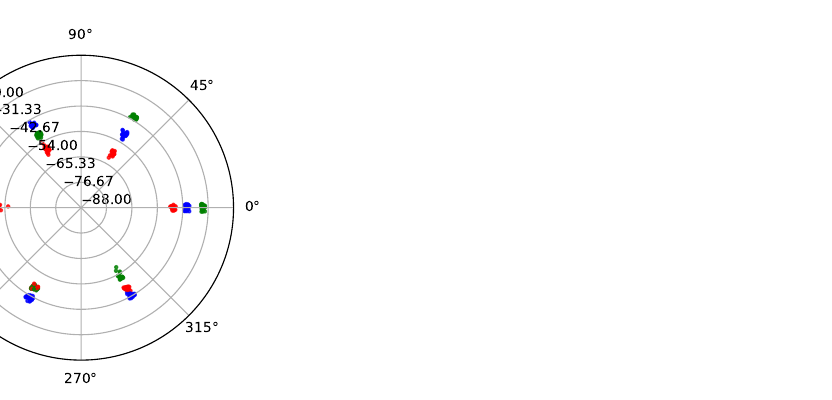
Figure 11. RSS measurements in dBm unit using six receiver antennas installed at the positions P1 to P6 on the measurement platform. Transmitter and receiver devices are 4 m apart in distance and all devices use the external 6 dBi omnidirectional antenna.